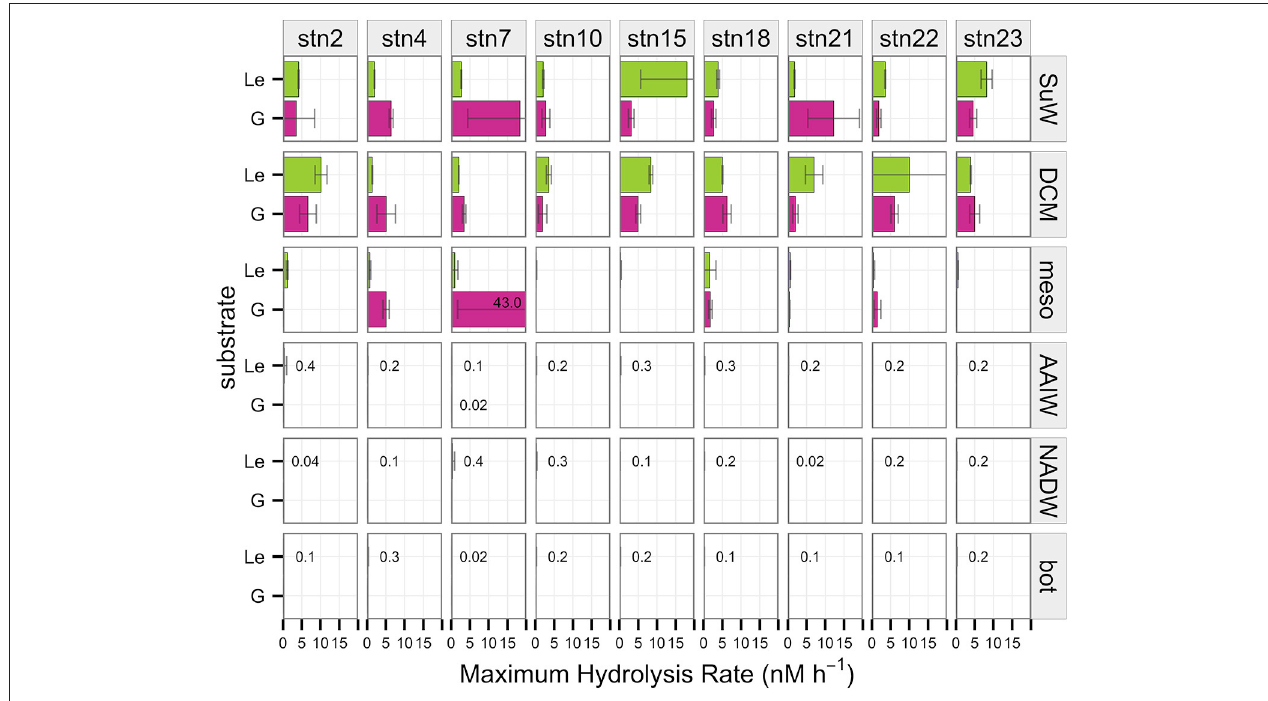
FIGURE 6 | Maximum potential hydrolysis rate (nM h − 1 ) of the monomeric substrates leucine (Le) and α -glucose (G) at each station (vertical panels) and depth (horizontal panels). Error bars indicate standard deviation of experimental triplicates. A particularly high hydrolysis rate of α -glucose at stn 7, mesopelagic depth indicated by the number in the panel. Low, non-zero hydrolysis rates in deep waters indicated by numbers in the figure